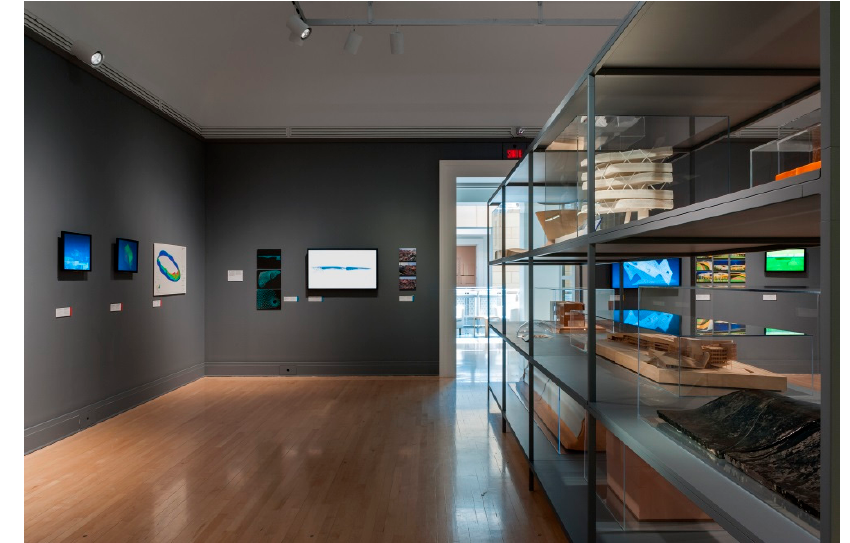
Figure 7. Archaeology of the Digital: Complexity and Convention, installation view of different models and pieces of projects shown in the exhibition, Canadian Centre for Architecture, 2016. Photograph: © CCA.